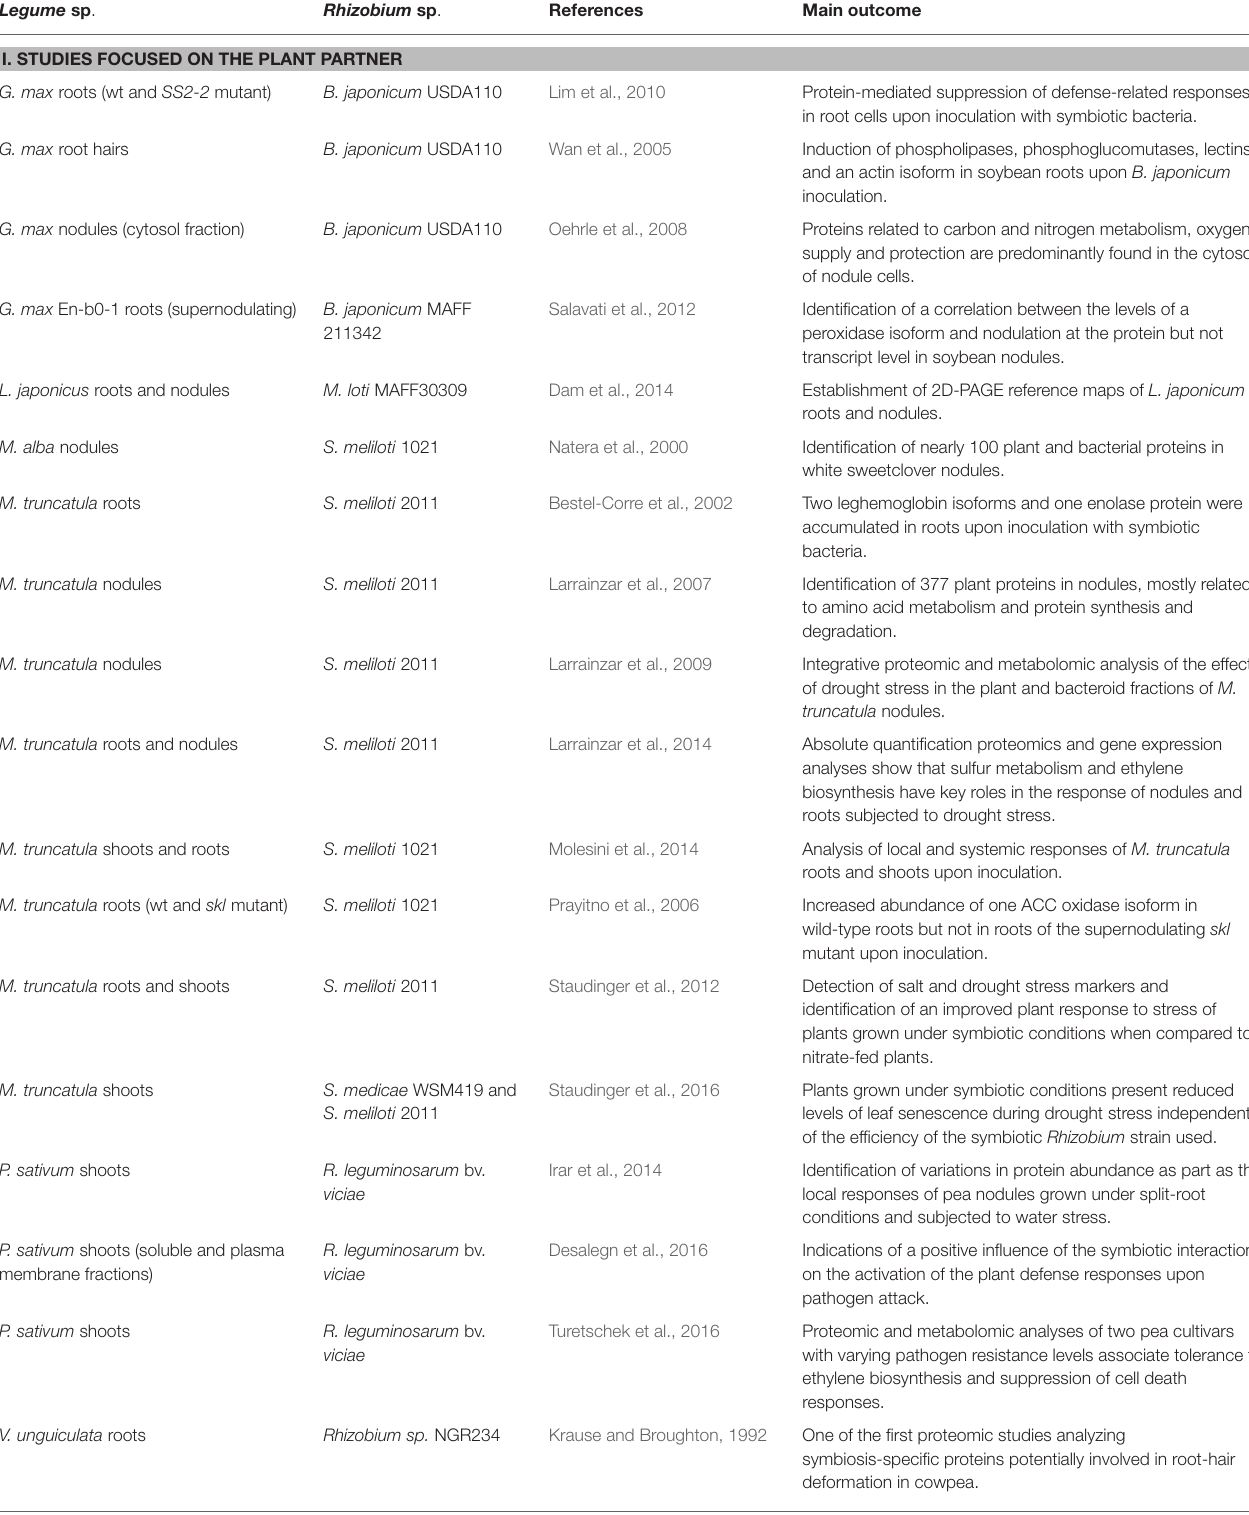
TABLE 1 | Summary of proteomic studies focused on the legume- Rhizobium symbiosis. Legume sp